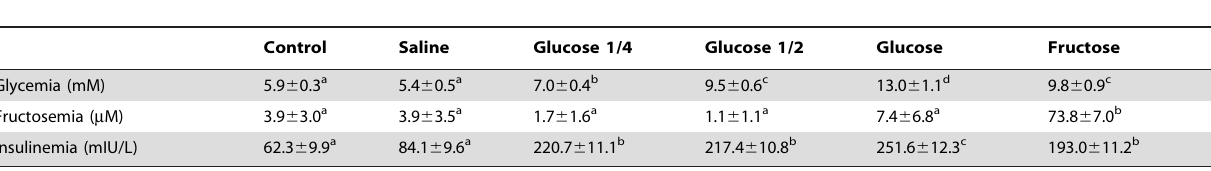
Table 1. Values of glycemia, fructosemia and insulinemia in rats subjected to either an oral glucose or fructose